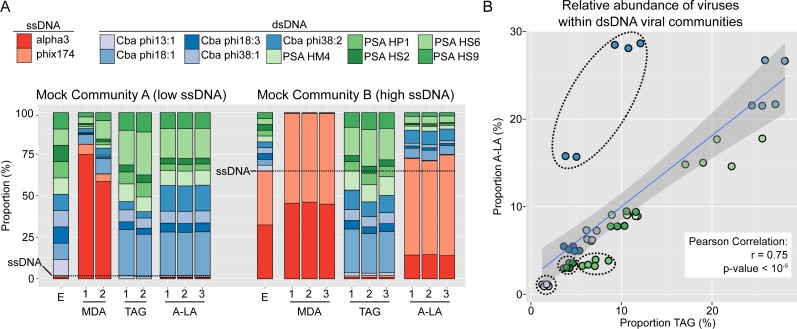
Comparison of amplification efficiency for ssDNA and dsDNA genomes of Multiple Displacement Amplification (MDA), Tagmentation (TAG) and Adaptase-Linker Amplification (A-LA) from mock community samples.(A) Composition of mock communities’ viromes prepared with MDA, TAG, and A-LA. For each community, the first bar displays the expected proportion of each virus (“E”), and replicates are noted with a number (1–3) when available. Expected proportions of ssDNA viruses are highlighted with a dashed horizontal line (1.8% and 64.9% of MCA and MCB respectively). (B) Correlation between the relative abundance of individual dsDNA viruses (within the dsDNA viral community) in TAG (x-axis) and A-LA (y-axis) viromes. The color code of circles is the same as in (A). Genomes for which the relative abundance distributions are significantly different in TAG vs A-LA are highlighted with dotted outline (Fig. S2).